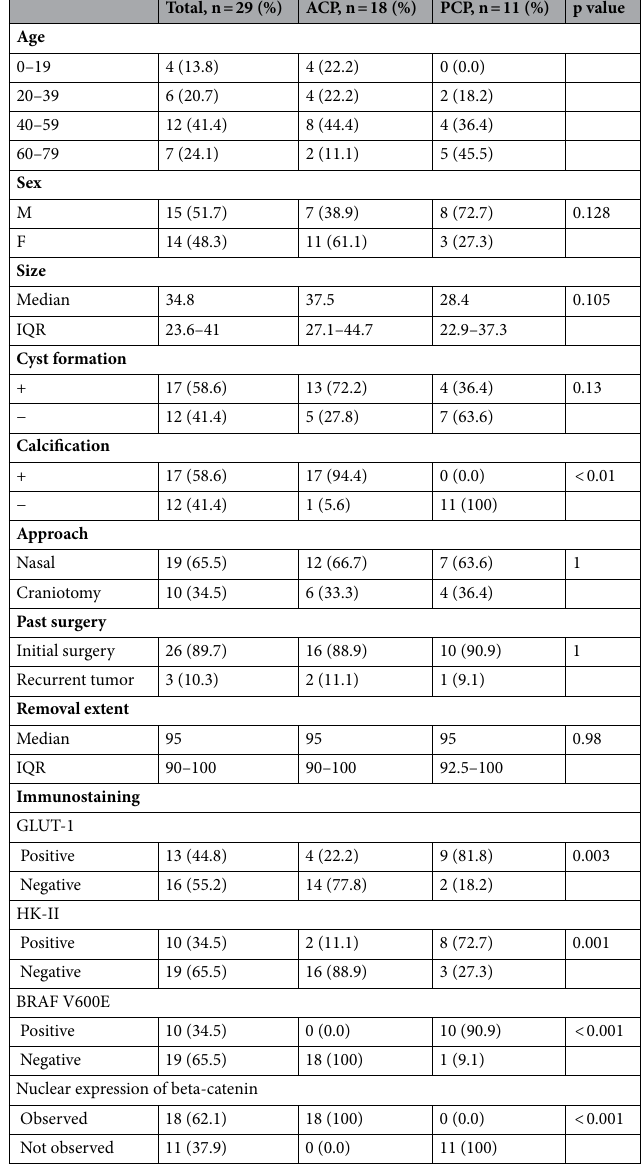
Table 1. Clinical and imaging characteristics, and immunostaining